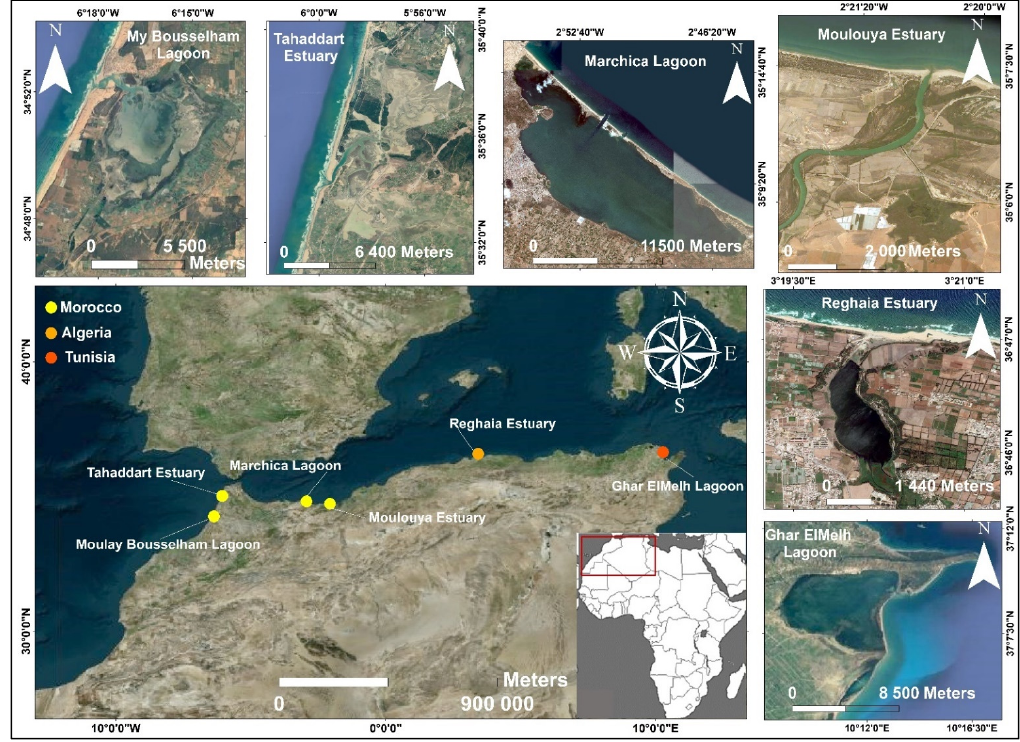
Figure 1. Location of the selected study sites .